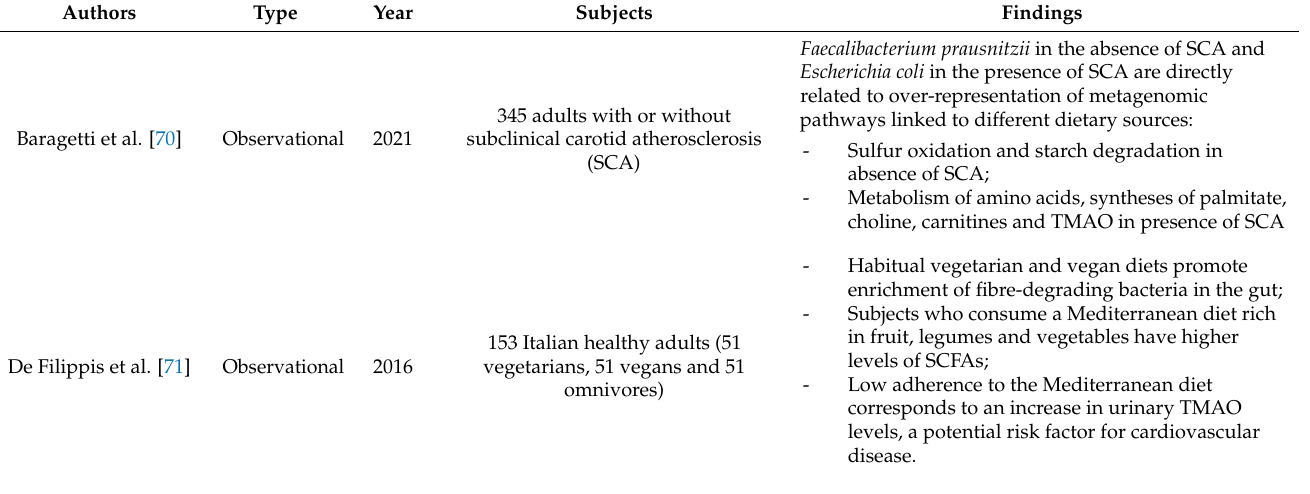
Table 6. Studies on the association between diet, gut microbiota and cardiovascular